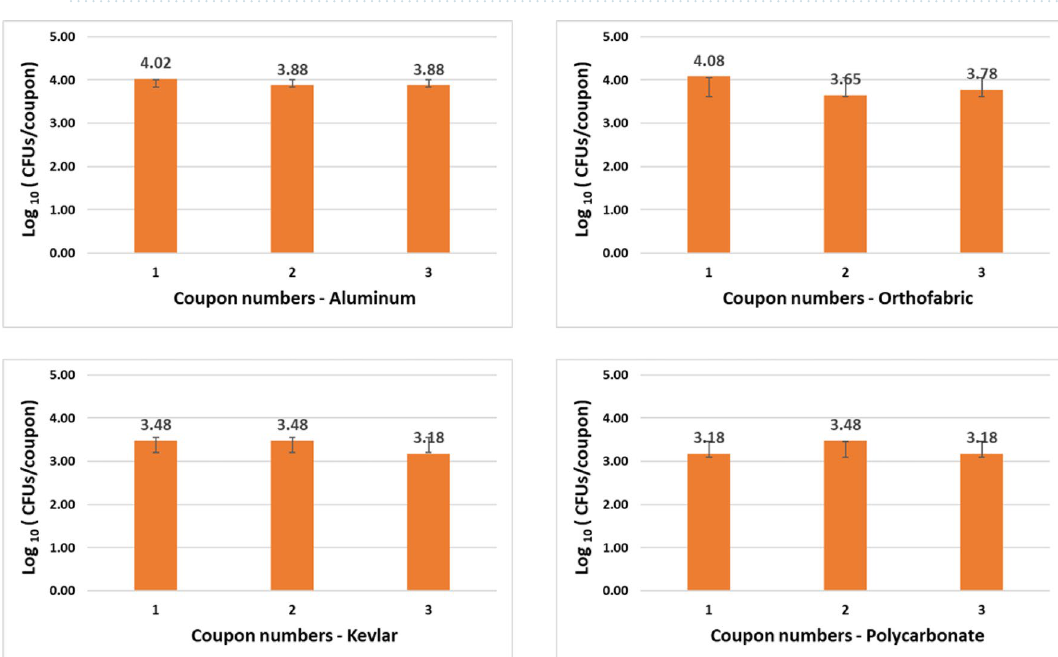
Figure 8. Data establishing consistent controls with B. subtilis inoculation, i.e., inoculating coupons of same material with same volume of B. subtilis culture resulted in consistent bacterial count per coupon with a maximum variation of 0.3 log10